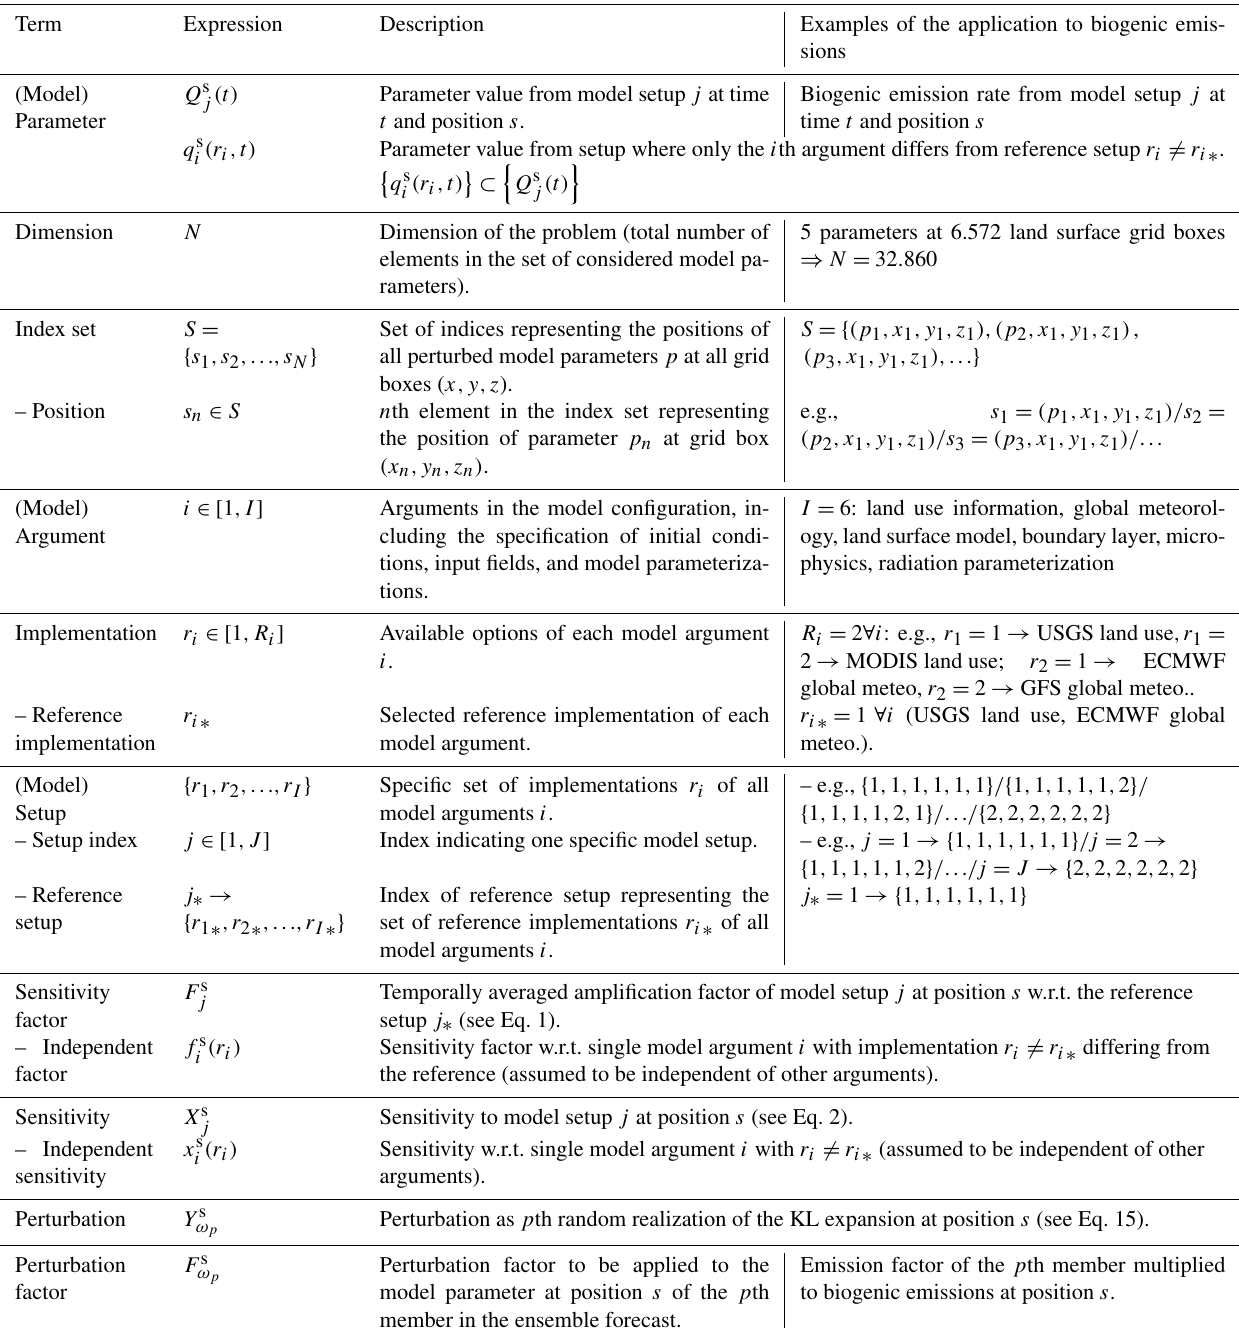
Table 1. Notations used in the concept of sensitivity estimation and the formulation of the algorithm (including examples). Term Expression Description Examples of the application to biogenic emis-